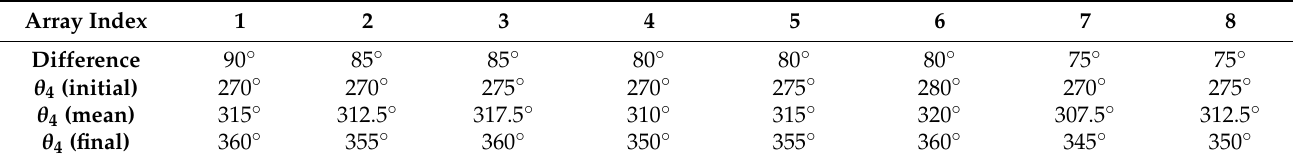
Table 2. Numerical example of the first 8 index of θ 4